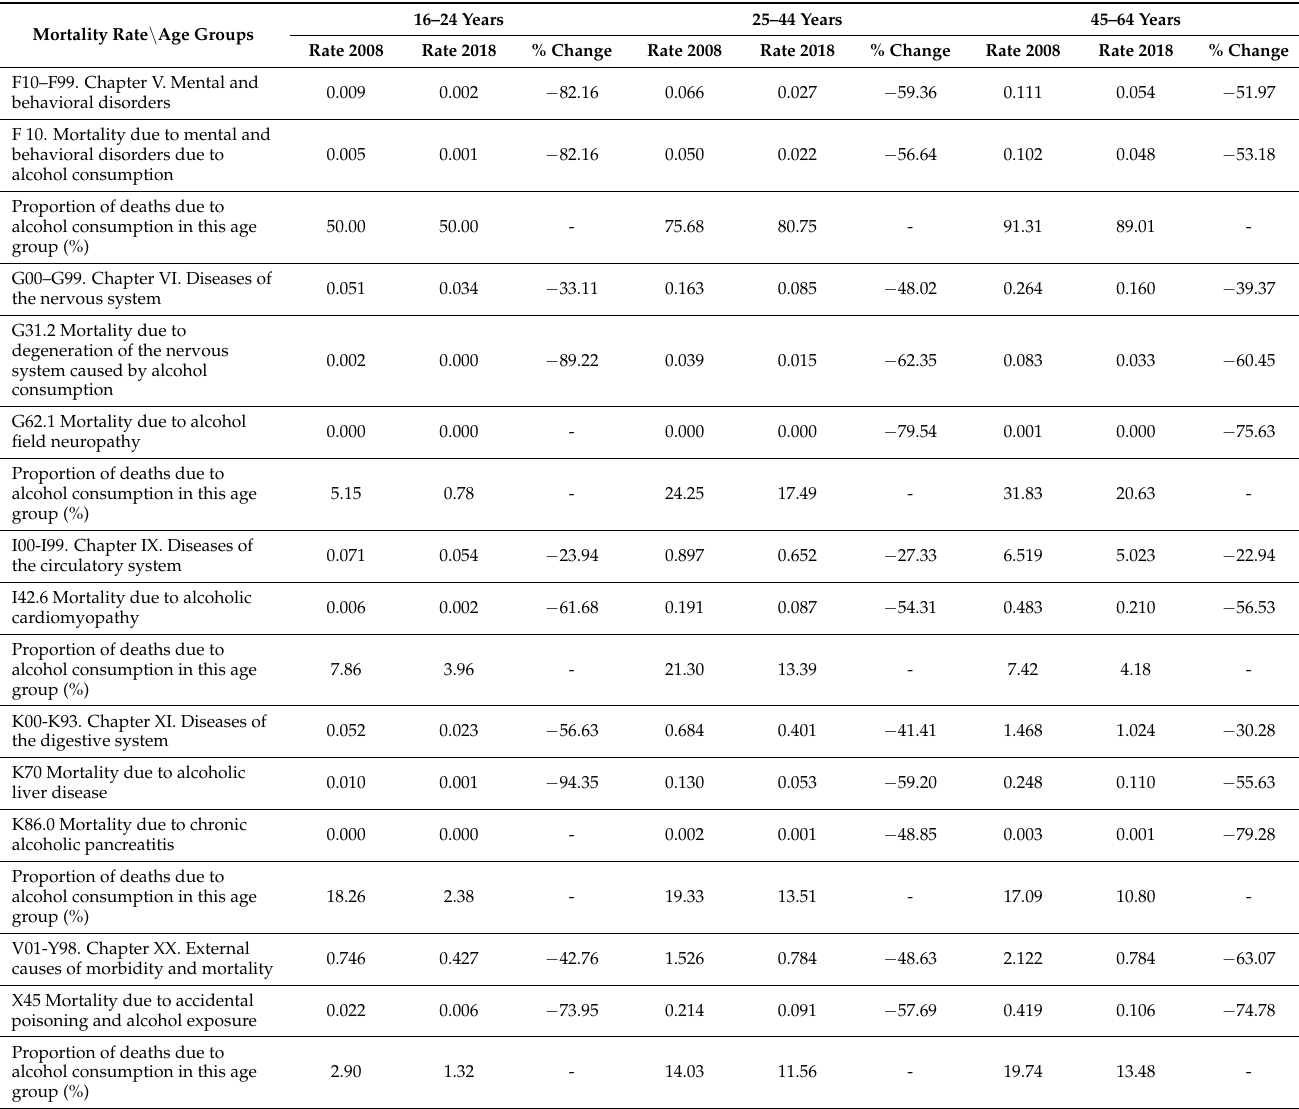
Table 8. Mortality of the working age population of Ukraine by causes of death and by age